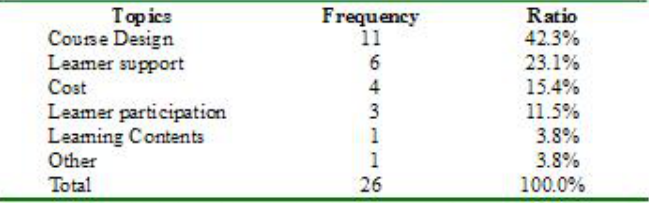
Table 6. The Topics of e-Learning Studies in Korea